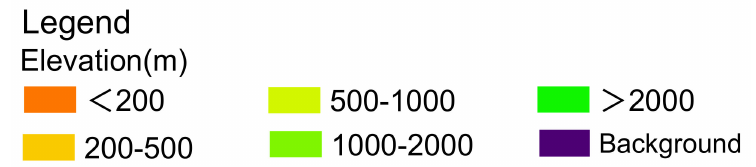
Figure 11. Distributions and area percentage of low-consistency areas of all land cover types at di ff erent elevations.